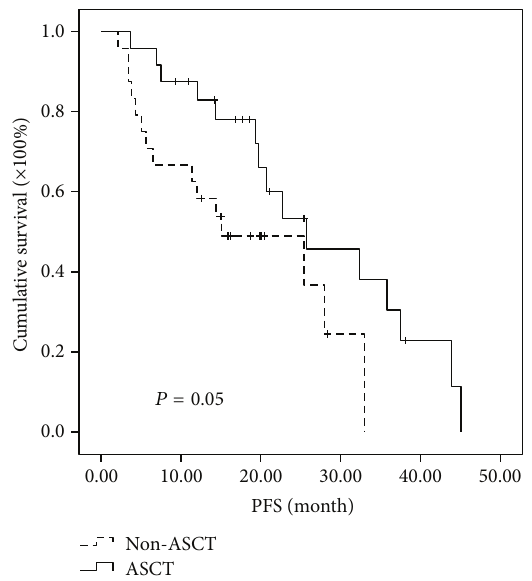
Figure 3: Comparison of PFS in the patients of ASCT group and non-ASCT group in the high-risk subgroup. The median PFS was prolonged 18.3 months in ASCT group (30.5 versus 11.2 months, 𝑃 < 0.001 ).